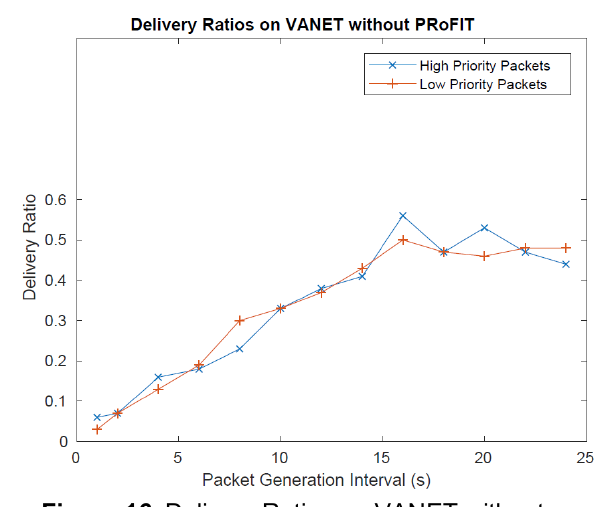
Figure 16. Delivery Ratios on VANET without PRoFIT